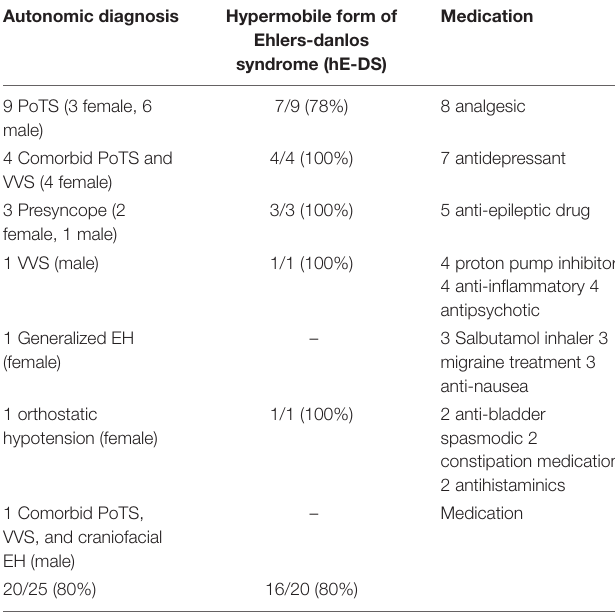
TABLE 1 | Overview of ASD referrals with a diagnosable form of autonomic